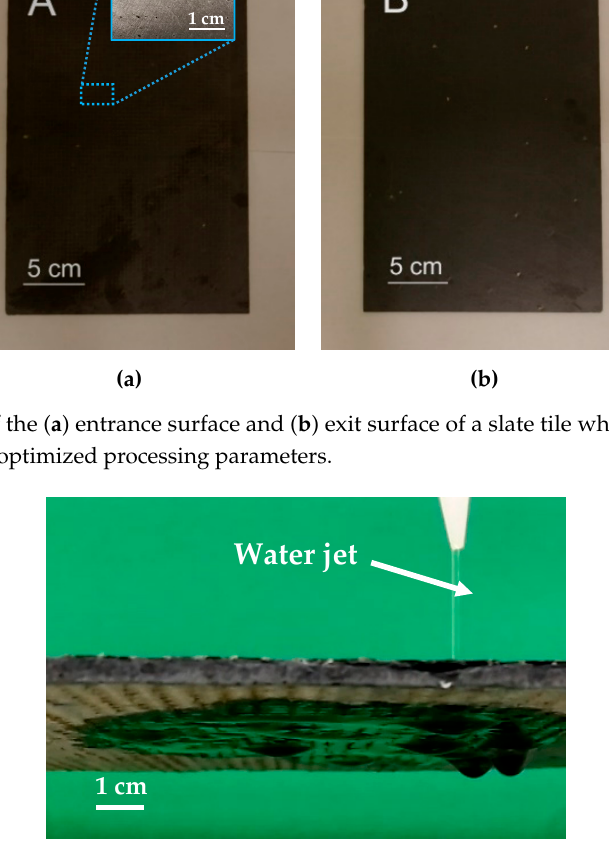
Figure 9. Image of a laser-drilled slate tile demonstrating the capability to act a water filter. A water jet is supplied to the upper face of the slate tile; water easily passes through the holes up to the lower face.